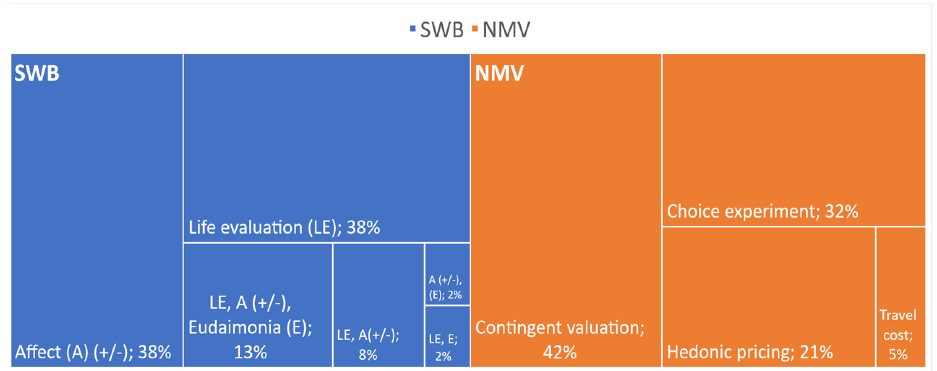
Figure 9. Frequency of the different methods employed per category of articles.